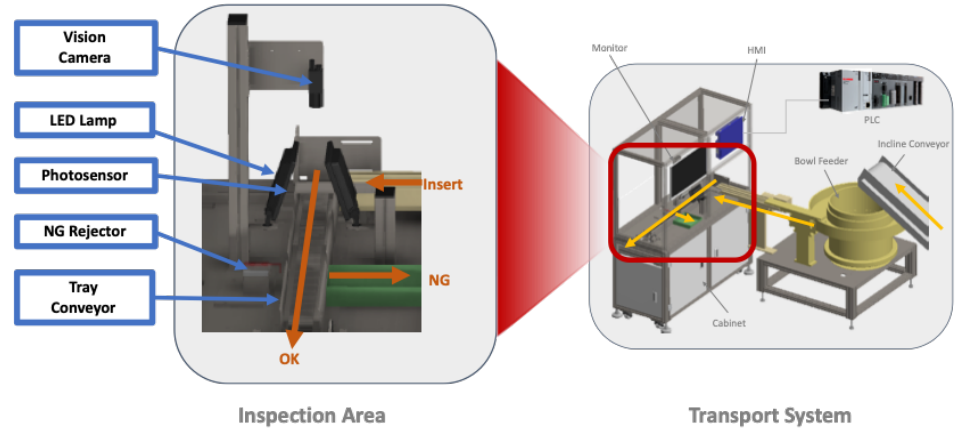
Figure 8. Closer view of inspection